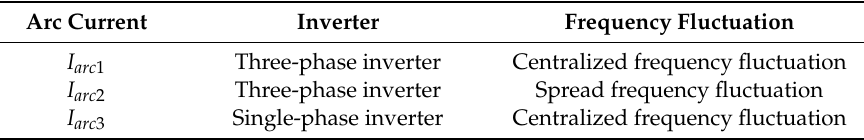
Table 1. Arc currents according to the frequency